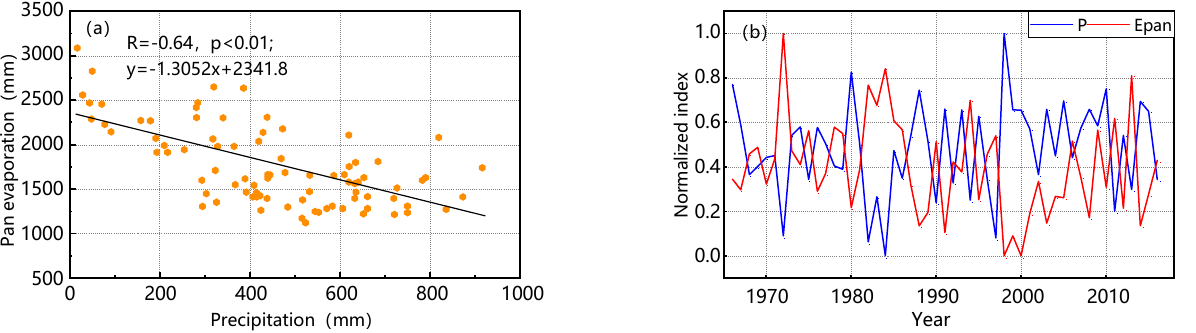
Figure 10. Comparison of Epan and precipitation at different timescales of the TP. ( a ) Correlation between the annual mean precipitation and Epan at each site, ( b ) interannual variation of normalized precipitation and Epan in August.